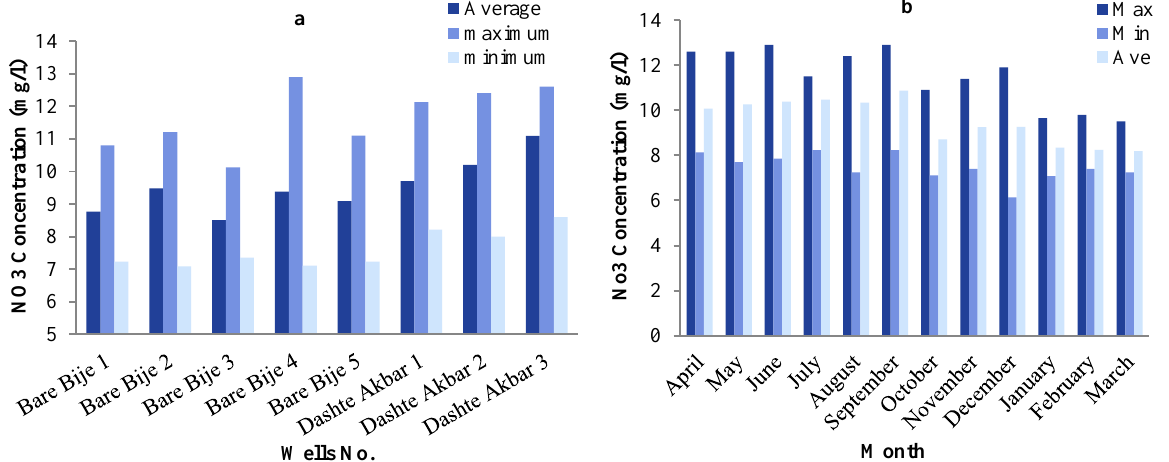
Figure 3. Average, maximum and minimum nitrate concentration in Dehloran drinking water sources in (mg/l- NO3-N) in variety of wells No. (a) and in variety of months in